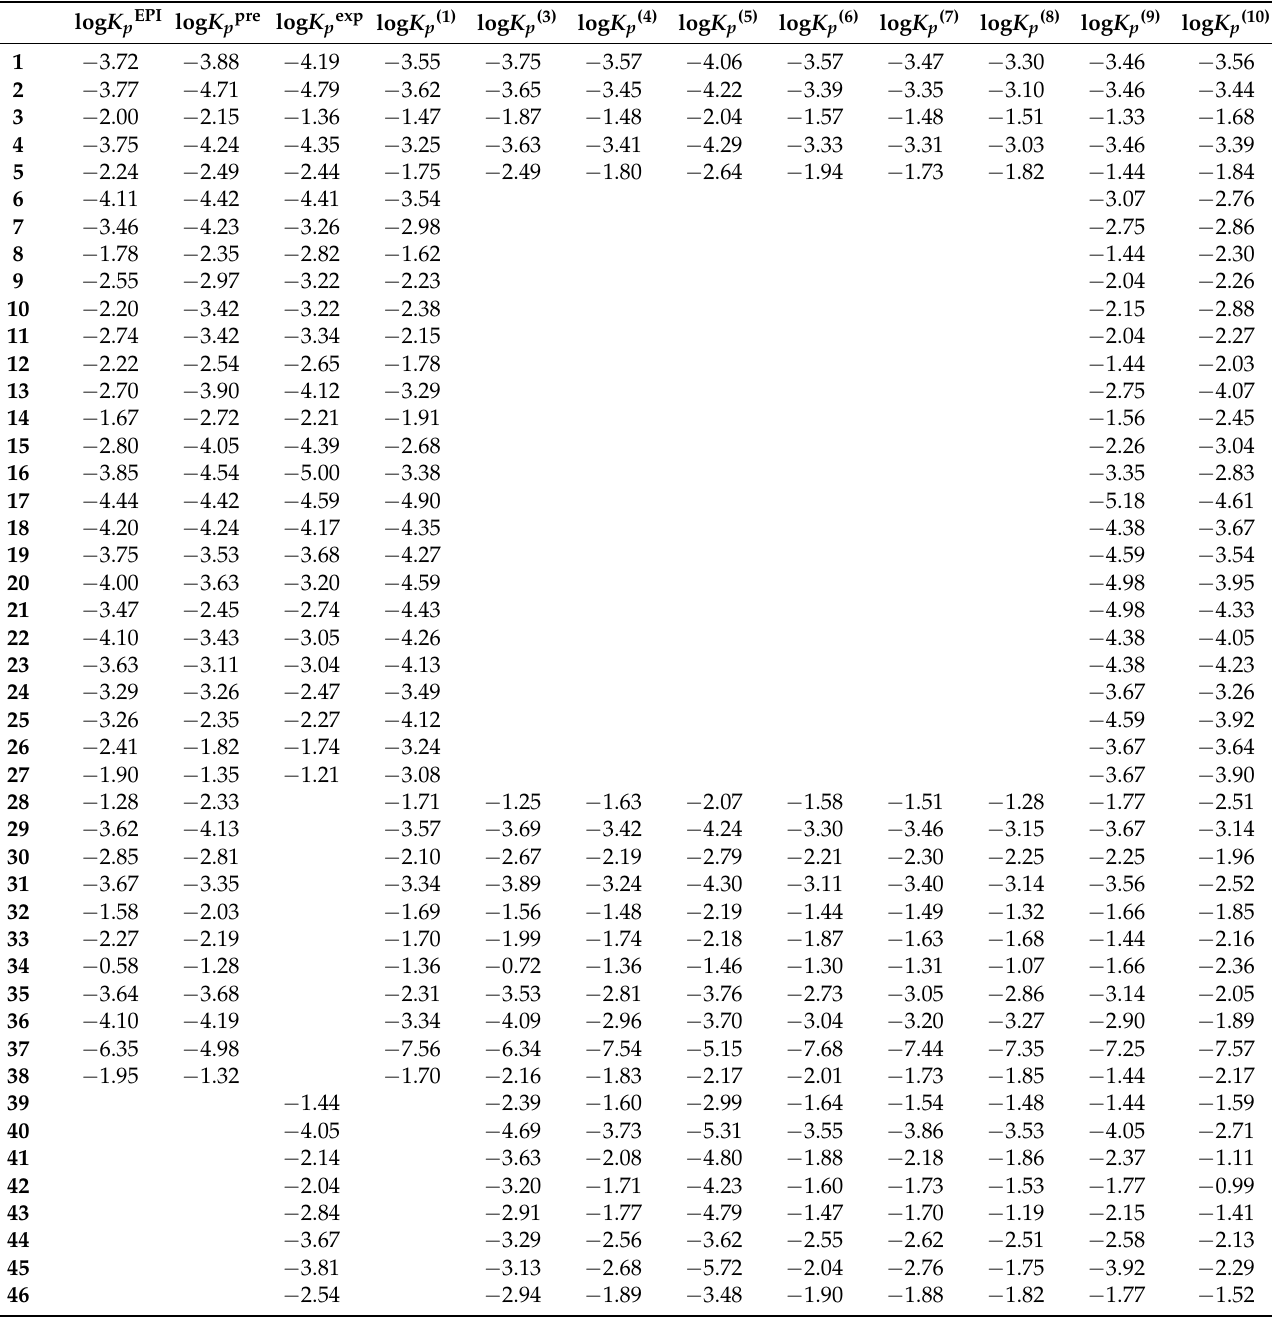
Table 1. Calculated and experimental log K p values for compounds 1 to 46